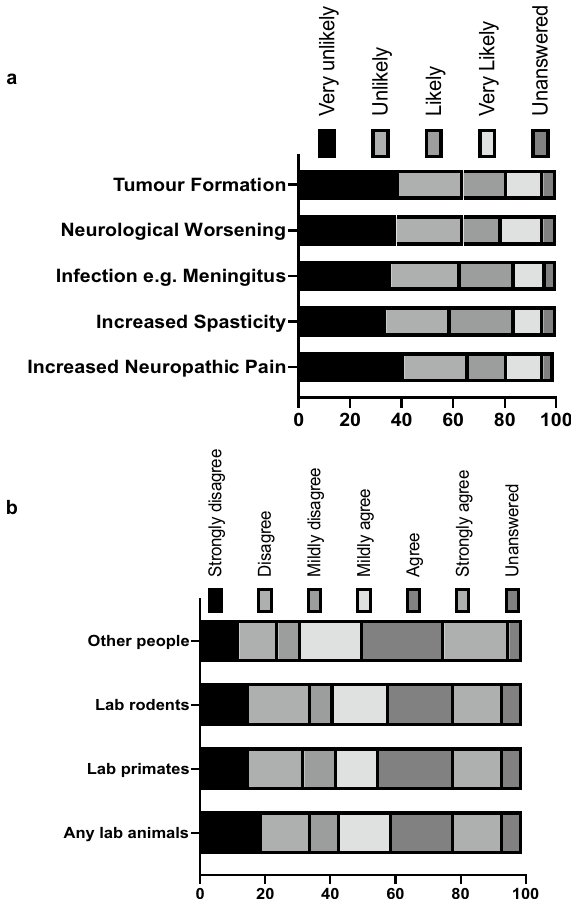
Figure 2. ( a ) Bar graph showing participant response to the question: “If the following risk of a treatment was explained to you by a clinician before volunteering for an experimental treatment or clinical trial, how likely would you be to take part?”. ( b ) Bar graph showing participant response to the statement: “I would be prepared to take part in an experimental treatment of clinical trial which had NOT first been tested on”.